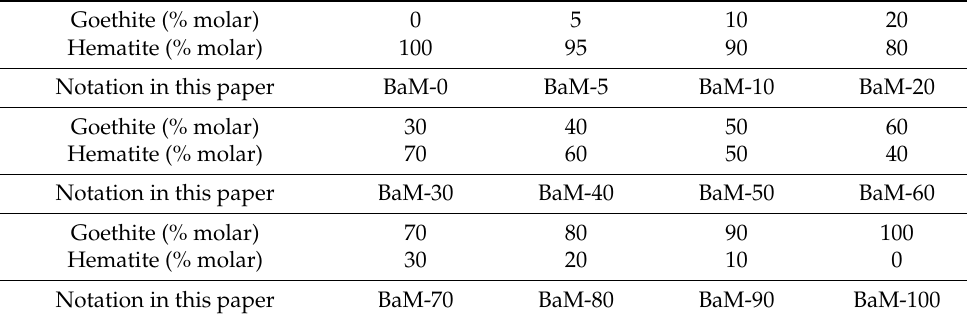
Table 3. Details on the prepared samples.